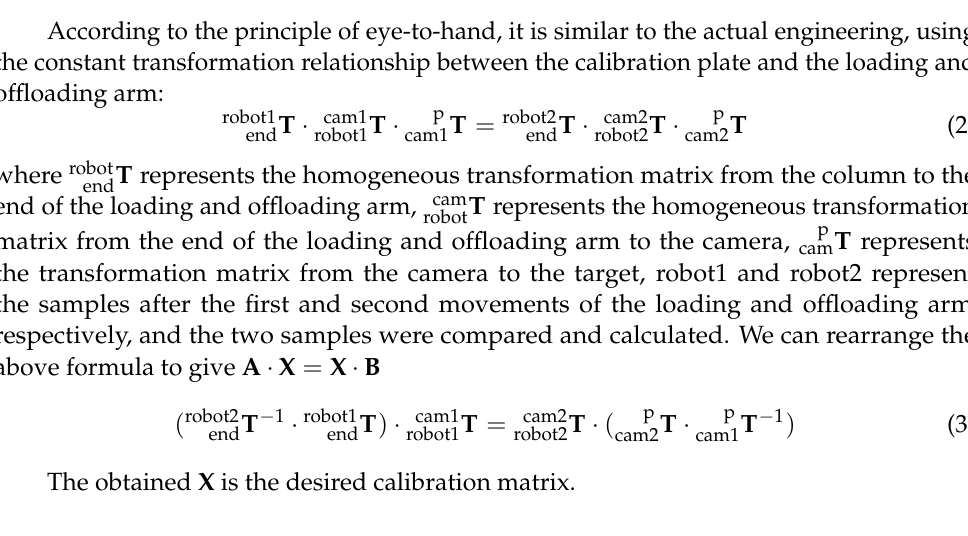
Figure 6. Calibration coordinate system transformation.